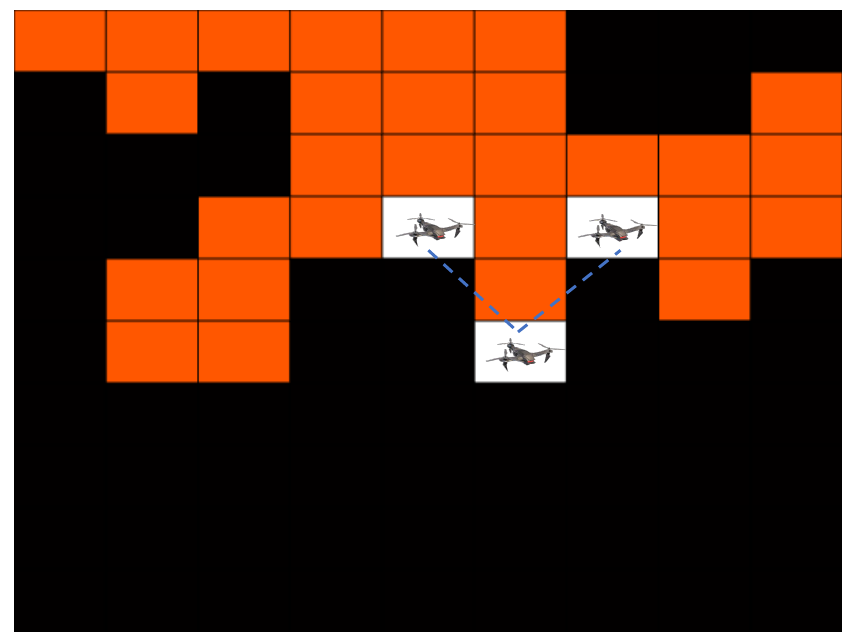
Figure 6. A multi-robot coverage scenario under continuous connectivity: the black, orange, and white cells represent the unvisited, previously visited, and the current cells of robots, respectively. The dotted lines represent the available communication channels among the robots. The goal is to cover the entire environment while maintaining a connected communication network throughout the